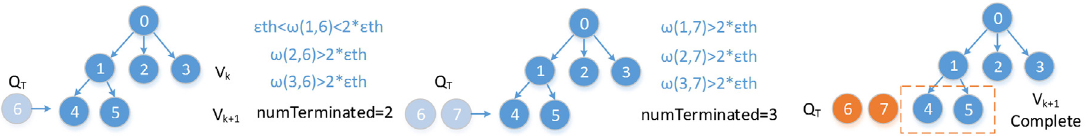
Figure 10. Running example of stopping criterion.